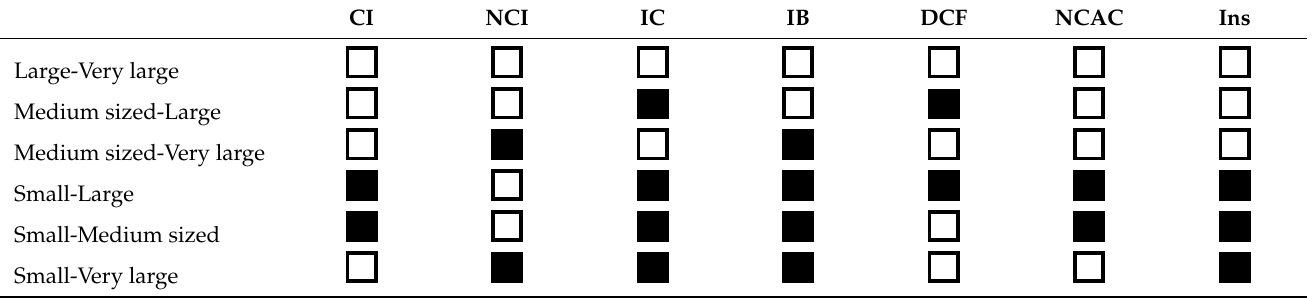
Table 5. The output of the pairwise firm size comparison.